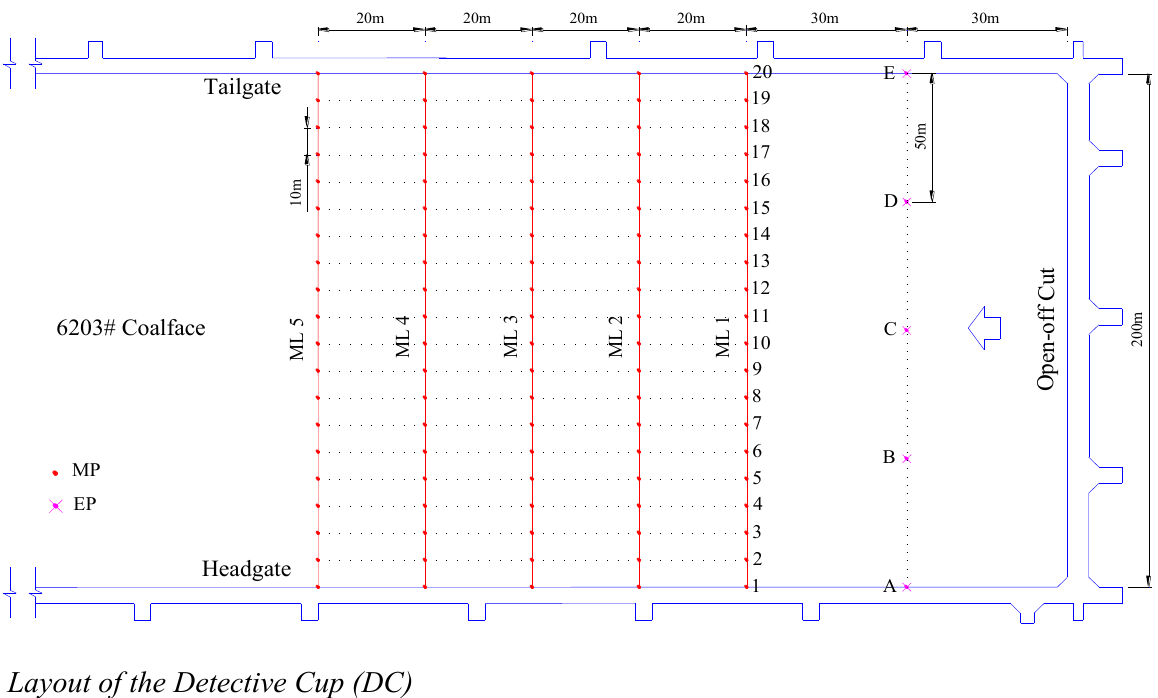
Figure 8. Layout schemes of the MP and